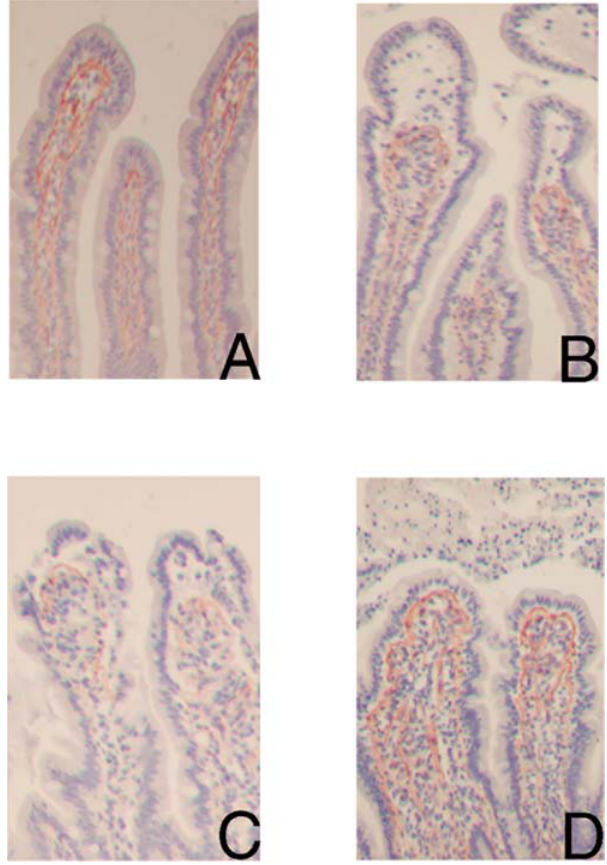
Figure 3. Characterization of the basement membrane with collagen IV staining in red (AEC) shows collagen IV positive cells directly beneath the epithelial layer in control jejunum (100 6 ). (A). Upon 30 minutes of ischemia, a clear retraction is found of the collagen IV positive cells from the basal pole of the epithelial cells at the tip of the villus, causing subepithelial spaces (B). After 25 minutes reperfusion, the retracted basement membrane is still observed (C). Within 60 minutes reperfusion, the collagen IV positive basement membrane is again attached to the epithelial lining (D).